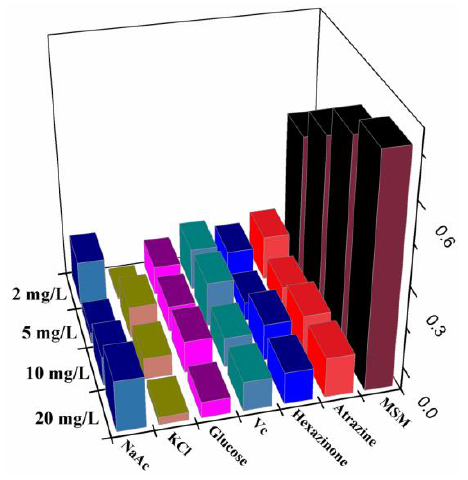
Figure 7. Absorption change ΔA523 of AuNPs in the presence of metsulfuron-methyl (MSM) and other interfering substances.